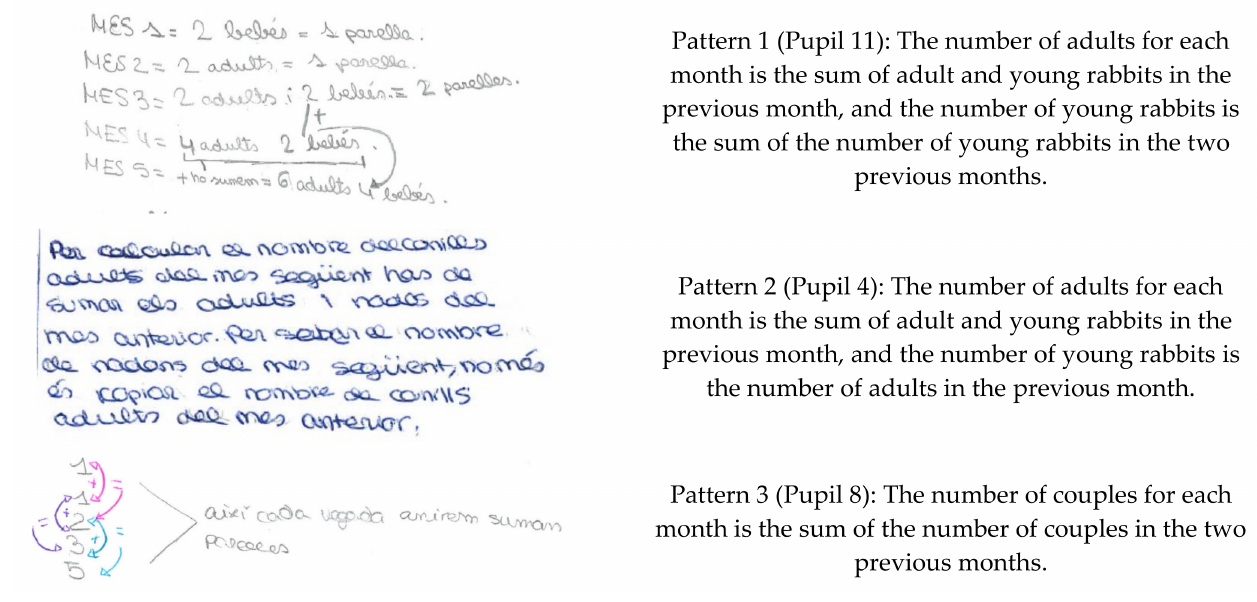
Figure 6. Examples of descriptions of the three patterns identified in pupils’